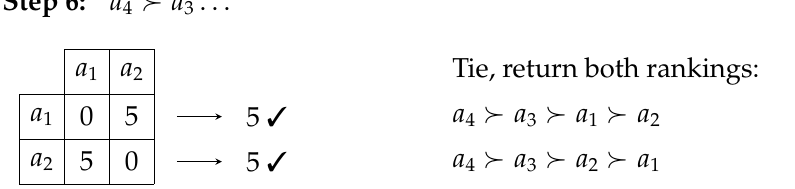
Figure 1. Recursive process followed by the algorithm over the profile of rankings in Table 1 in order to determine the tentative solutions, whose score will be later computed to determine the winning ranking(s) according to the Kemeny